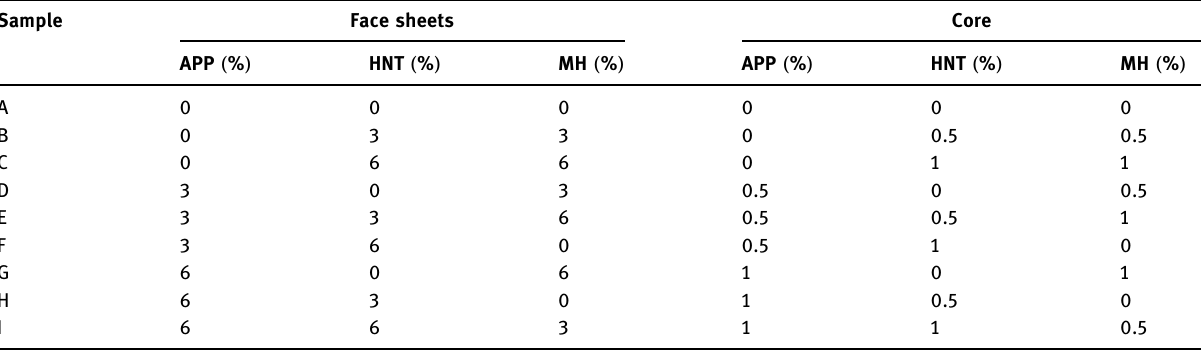
Table 1: L9 orthogonal array of Taguchi DOE for the face sheets at three levels of 0, 3, and 6% and for the core at three levels of 0, 0.5, and 1% Sample